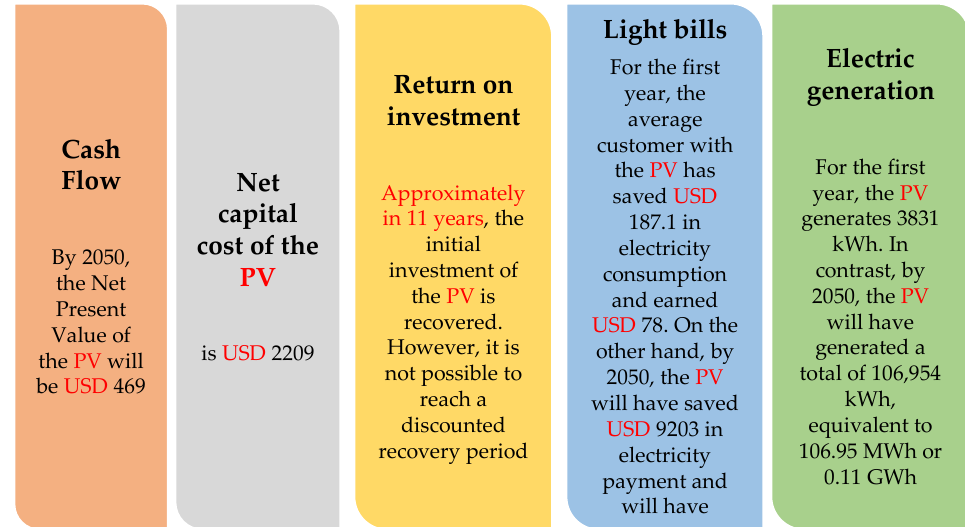
Figure 14. Financial results in SAM of the PV under study. Source: Adapted from simulation in SAM.